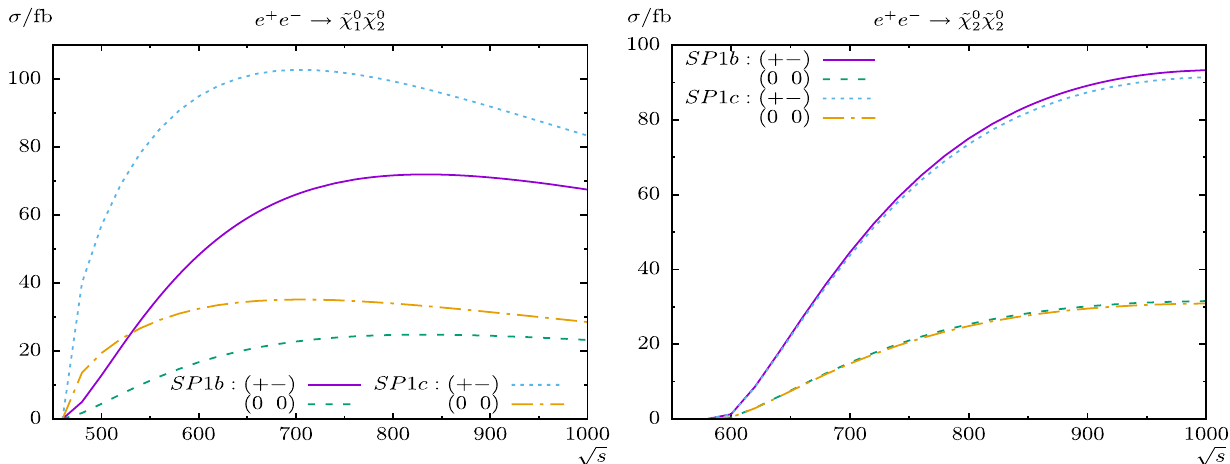
) . Tree cross n (cid:4) ization of the positrons/electrons, whereas ( 0 0 ) denotes unpolarized